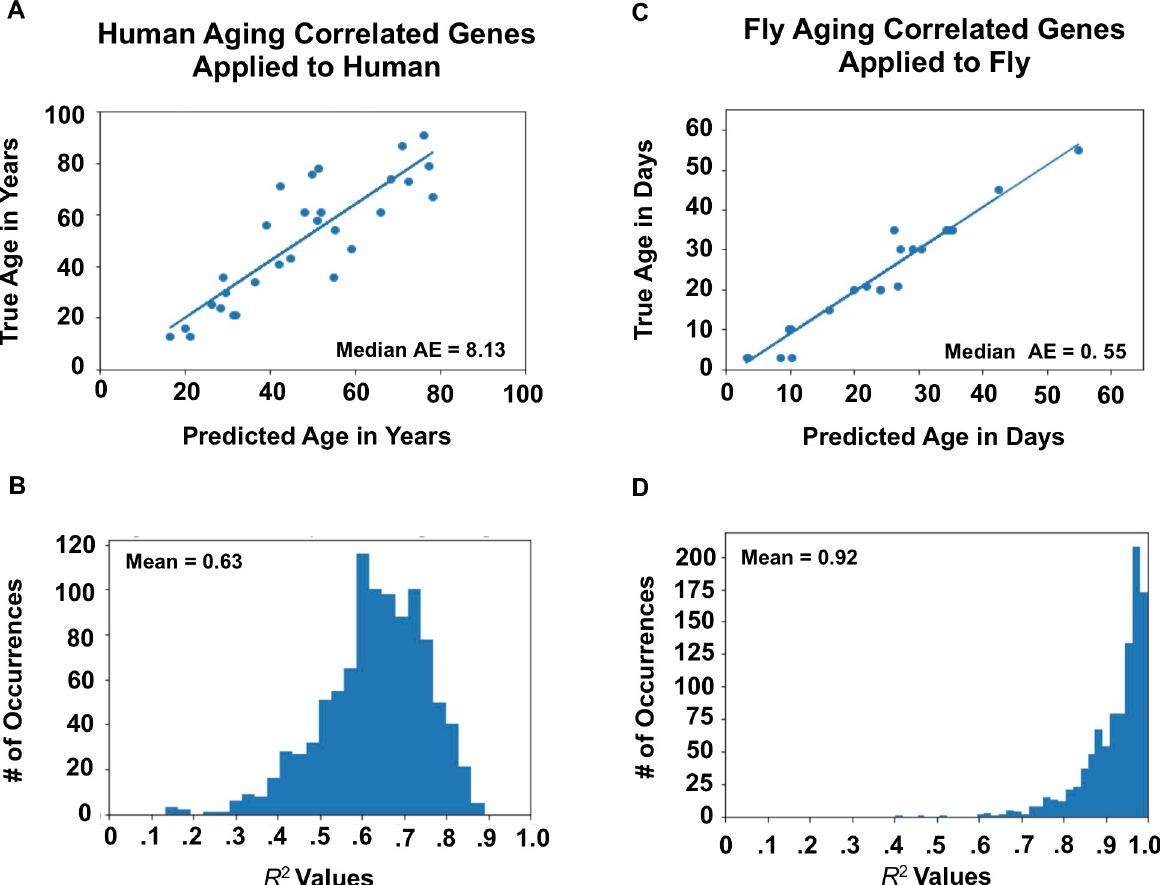
Fig 2. Biological age prediction using XGBoost across species. A) Sample regression analysis using all human genes to predict human age. B) Histogram of R 2 values for predicting human age with all available human genes with a mean R 2 of 0.61. C) A sample regression analysis with all Drosophila genes to predict Drosophila age. D) Histogram of R 2 values for predicting Drosophila age using all available Drosophila genes with a mean R 2 of 0.93. All results calculated using XGBoost. Histograms represent averages across 1000 bootstrapped random samplings where the regressor or classifier was trained on 75% of the samples and tested on 25% with values reported as the mean across 1000 iterations. Median AE stands for Median Average Error.